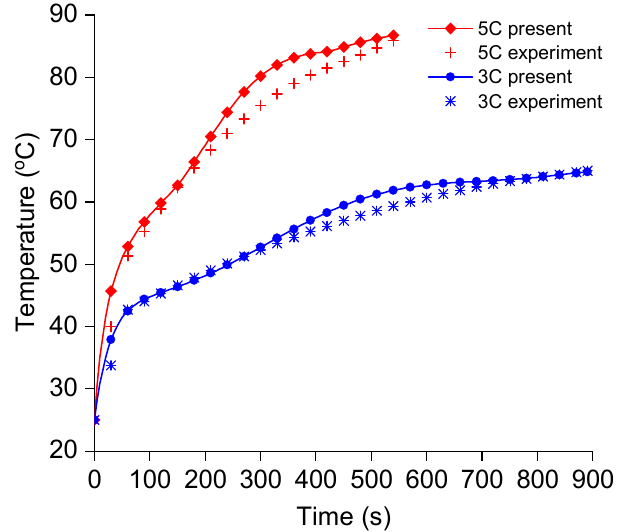
Figure 5. Comparison of the 1D model and the experimental maximum temperatures in the battery.